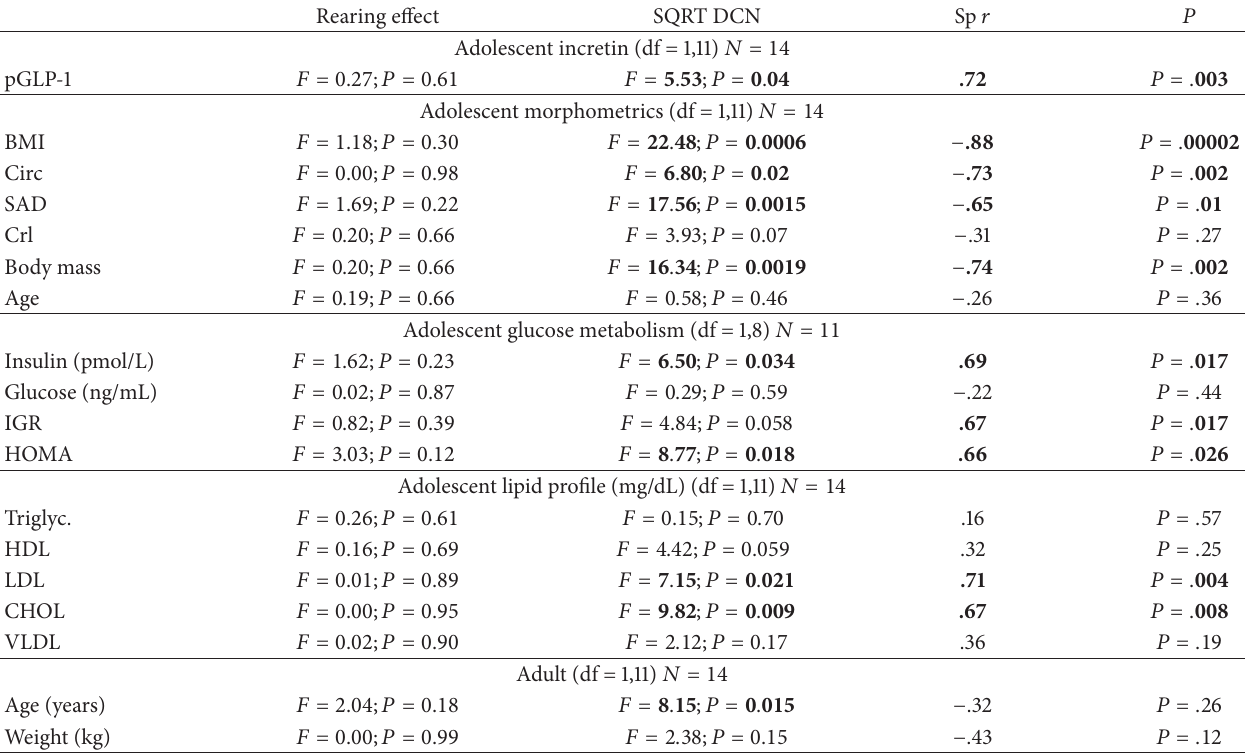
Table 1: Predictors of neurogenesis rates (square root doublecortin counts) and rearing effects with post hoc Spearman correlation verifica-